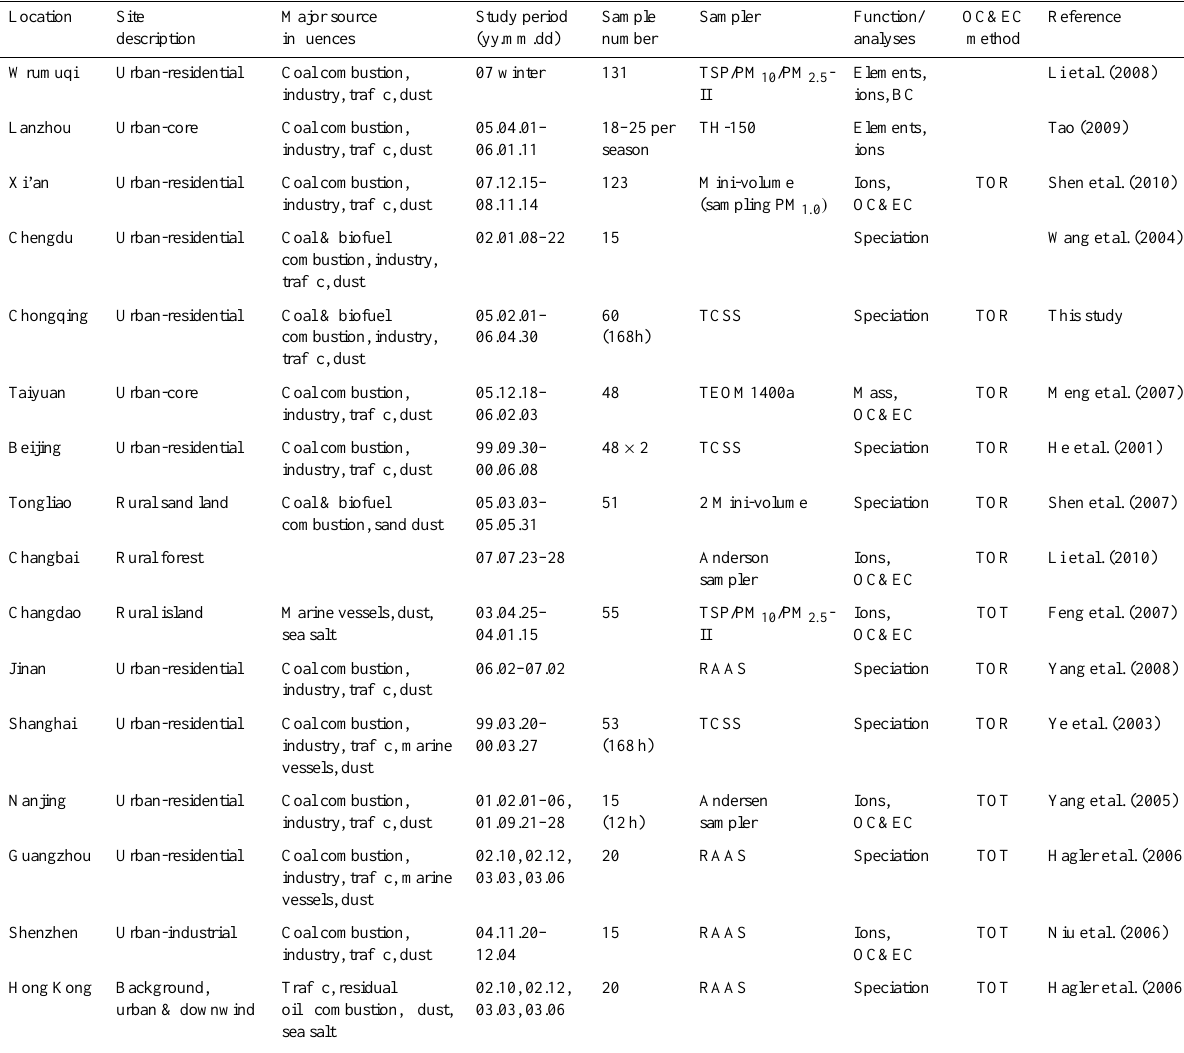
Table 1. Brief introduction of PM 2 . 5 sampling and analyses in selected locations across